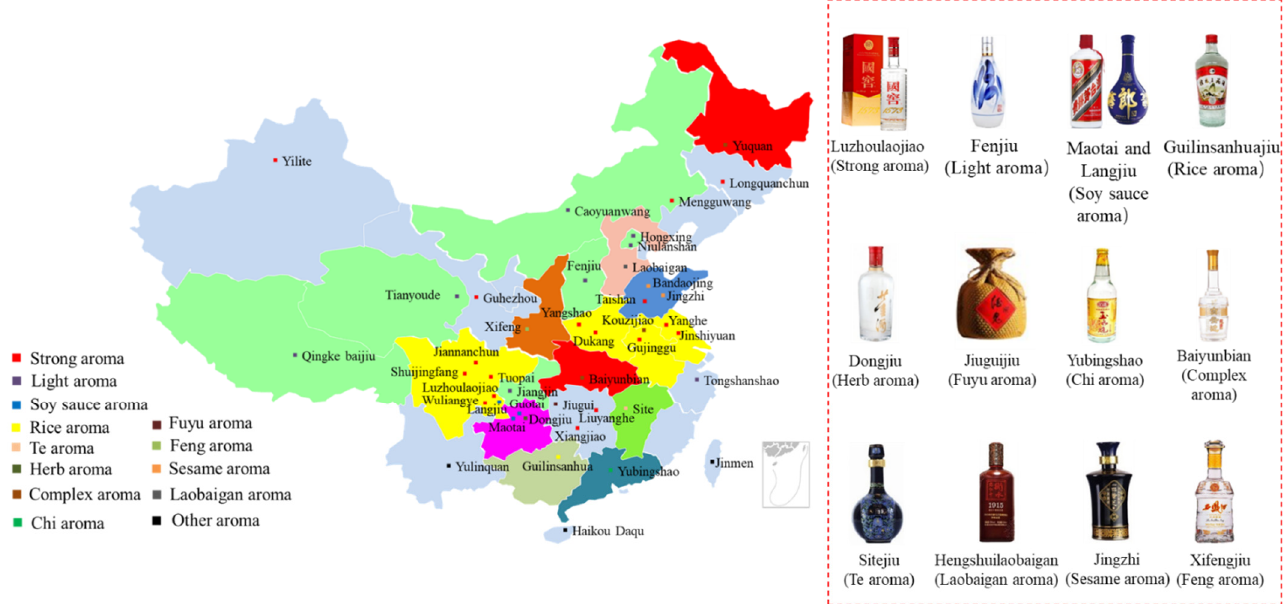
Figure 3. Distribution and representation of mainstream aroma-types of baijius in China.